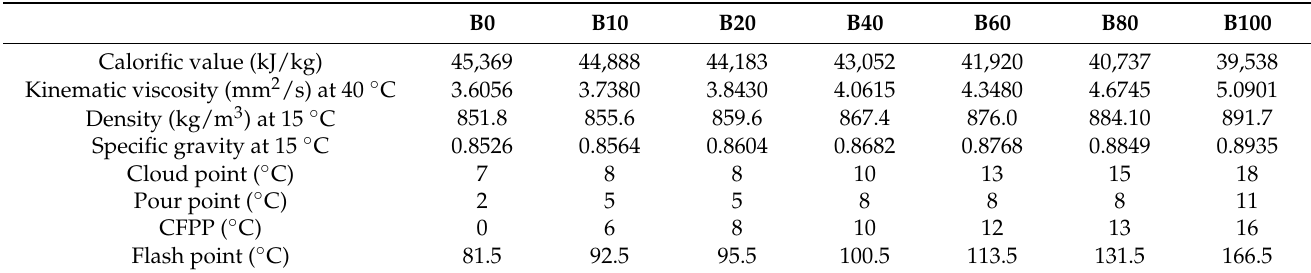
Table 5. Fuel properties of Karanja biodiesel-diesel blends by DT method.